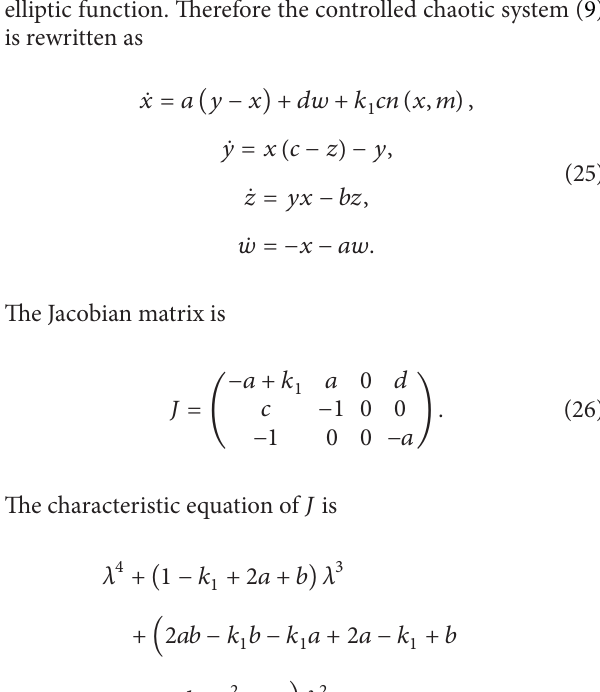
Figure 7: The solutions of the drive and response systems with control law. (a) Signals 𝑥 1 (the dashed line) and 𝑥 2 (the solid line). (b) Signals 𝑦 1 (the dashed line) and solid